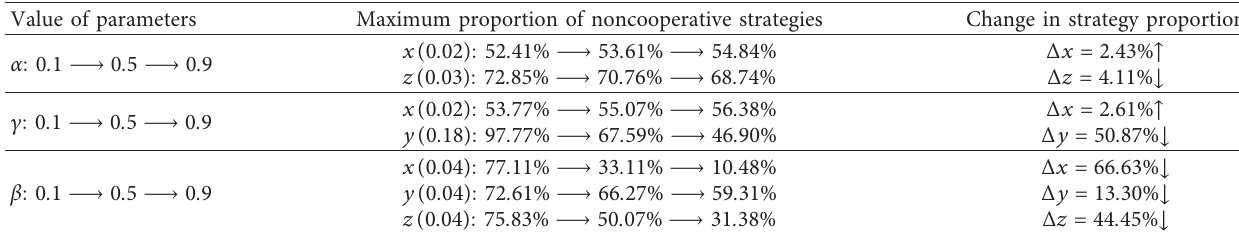
Table 3: Impact of incentive and penalty parameters on the changing degree of subject strategy. Value of parameters Maximum proportion of noncooperative strategies Change in strategy